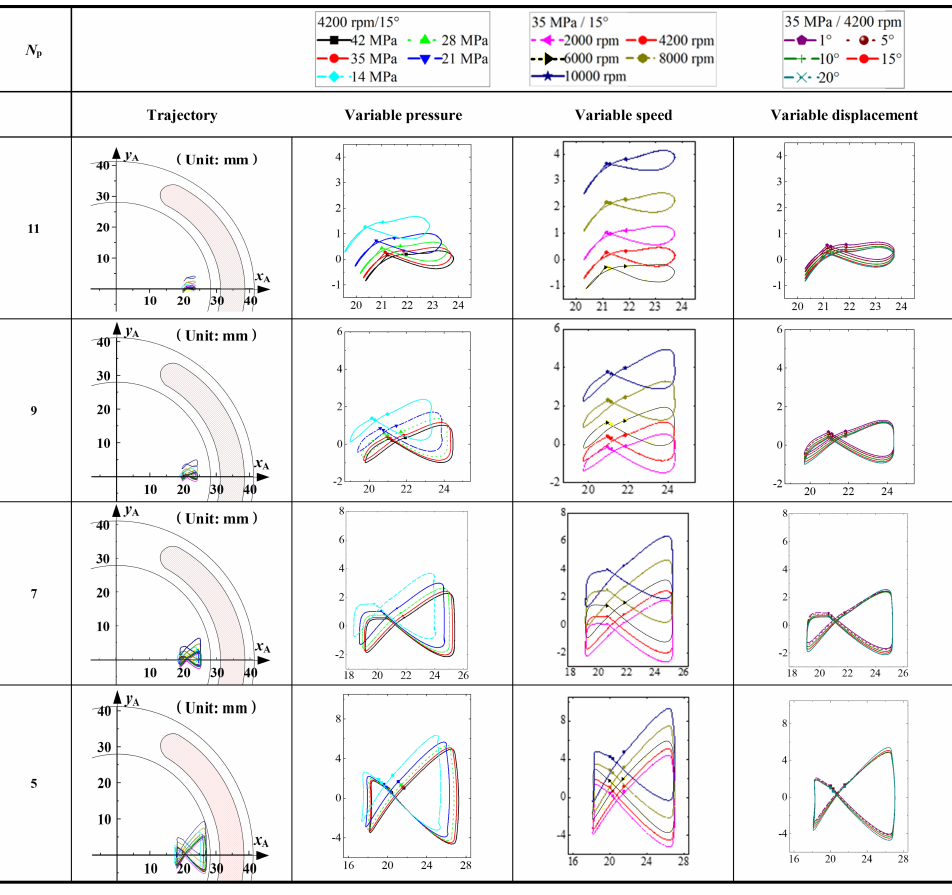
Figure 22. F z action point